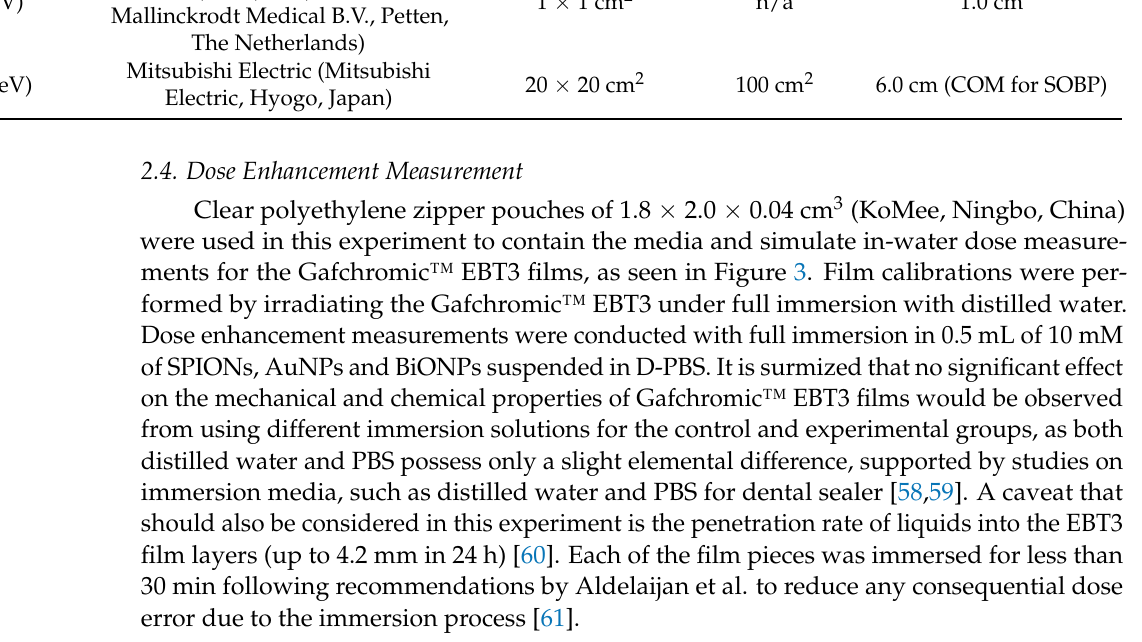
Table 3. Overview description of film irradiation setups.